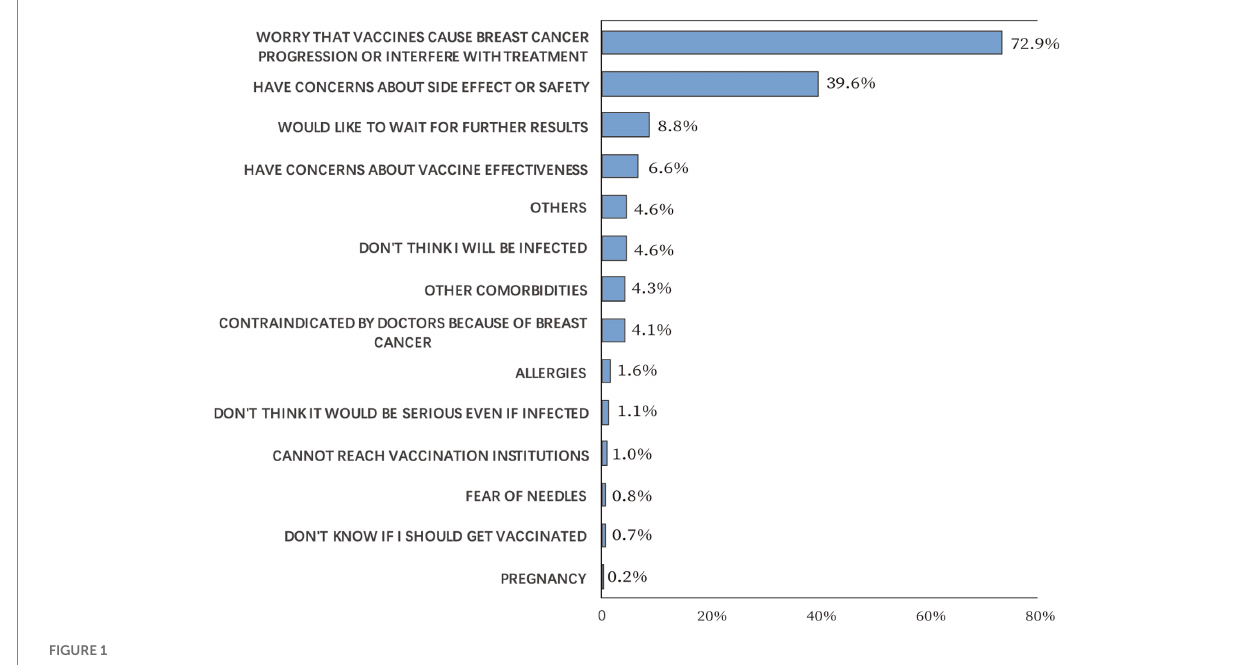
FIGURE 1 Reasons for